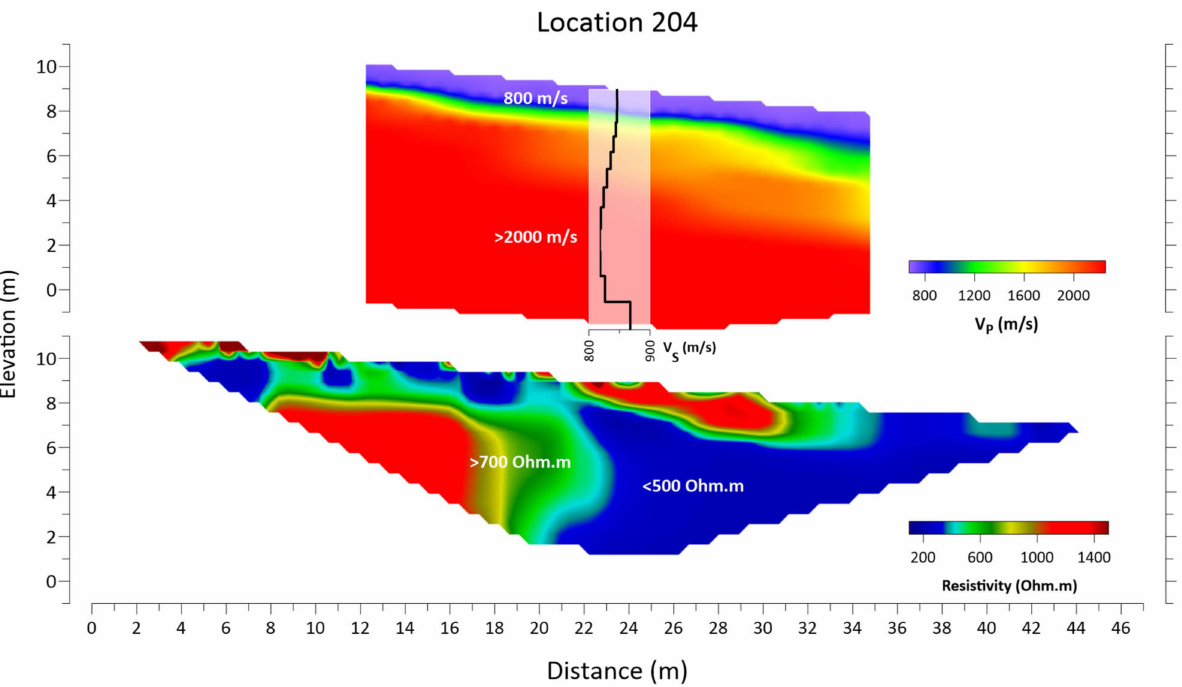
Figure 6. SRT and MASW ( top ) and ERT ( bottom ) sections at location 204, investigating the breccia formation ( M sc